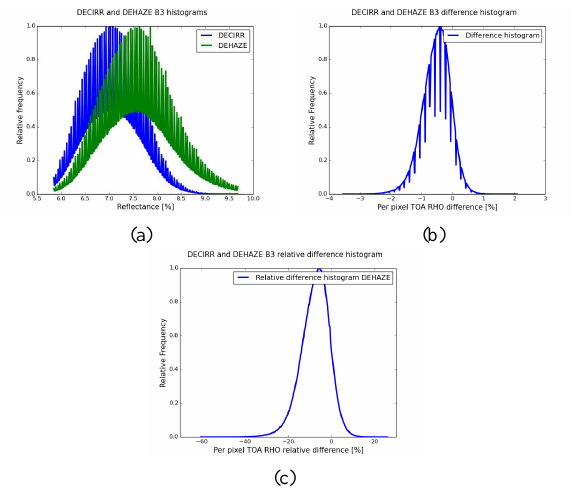
Figure 5: The Sentinel-2 1.38 µ m and the CTM decirrus re- sults (Band 3 TOA reflectance): a) histograms, b) difference his- togram, c) relative difference histogram.